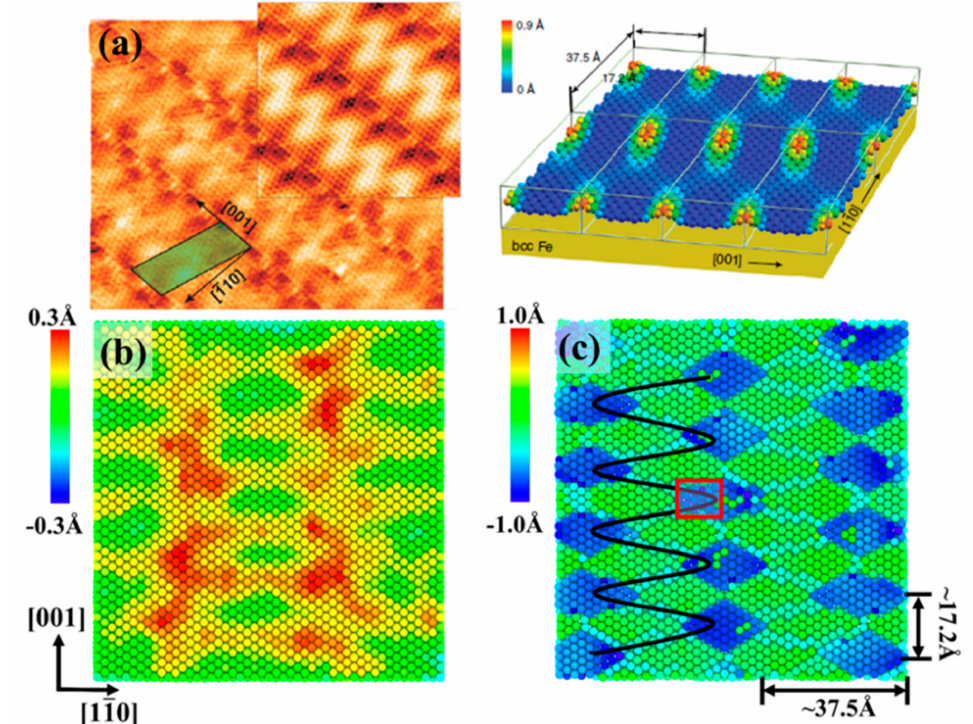
Figure 3. ( a ) Close-up STM image and positions of Gr/Fe (110) interface calculated by DFT [30], atomic structures from MD simulations using ( b ) LJ and ( c ) EAM potentials of